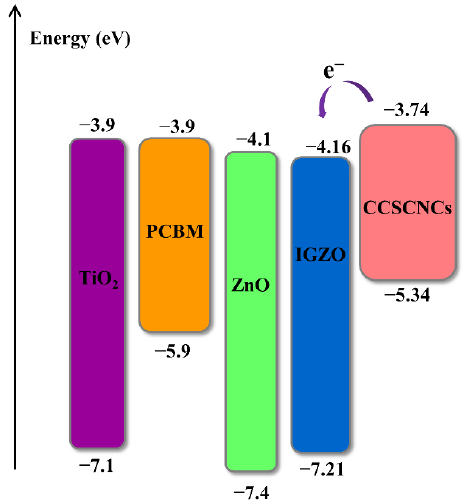
Figure 5. Band alignment between ETL materials and CCSCNCs. Table 5. Performance parameters of different ETMs as ETL.